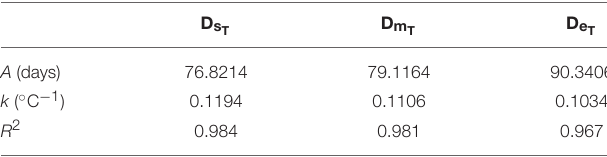
TABLE 2 | Parameters for incubation times to hatch start, median and end dates, estimated using egg incubation data for A. marinus (Régnier et al.,